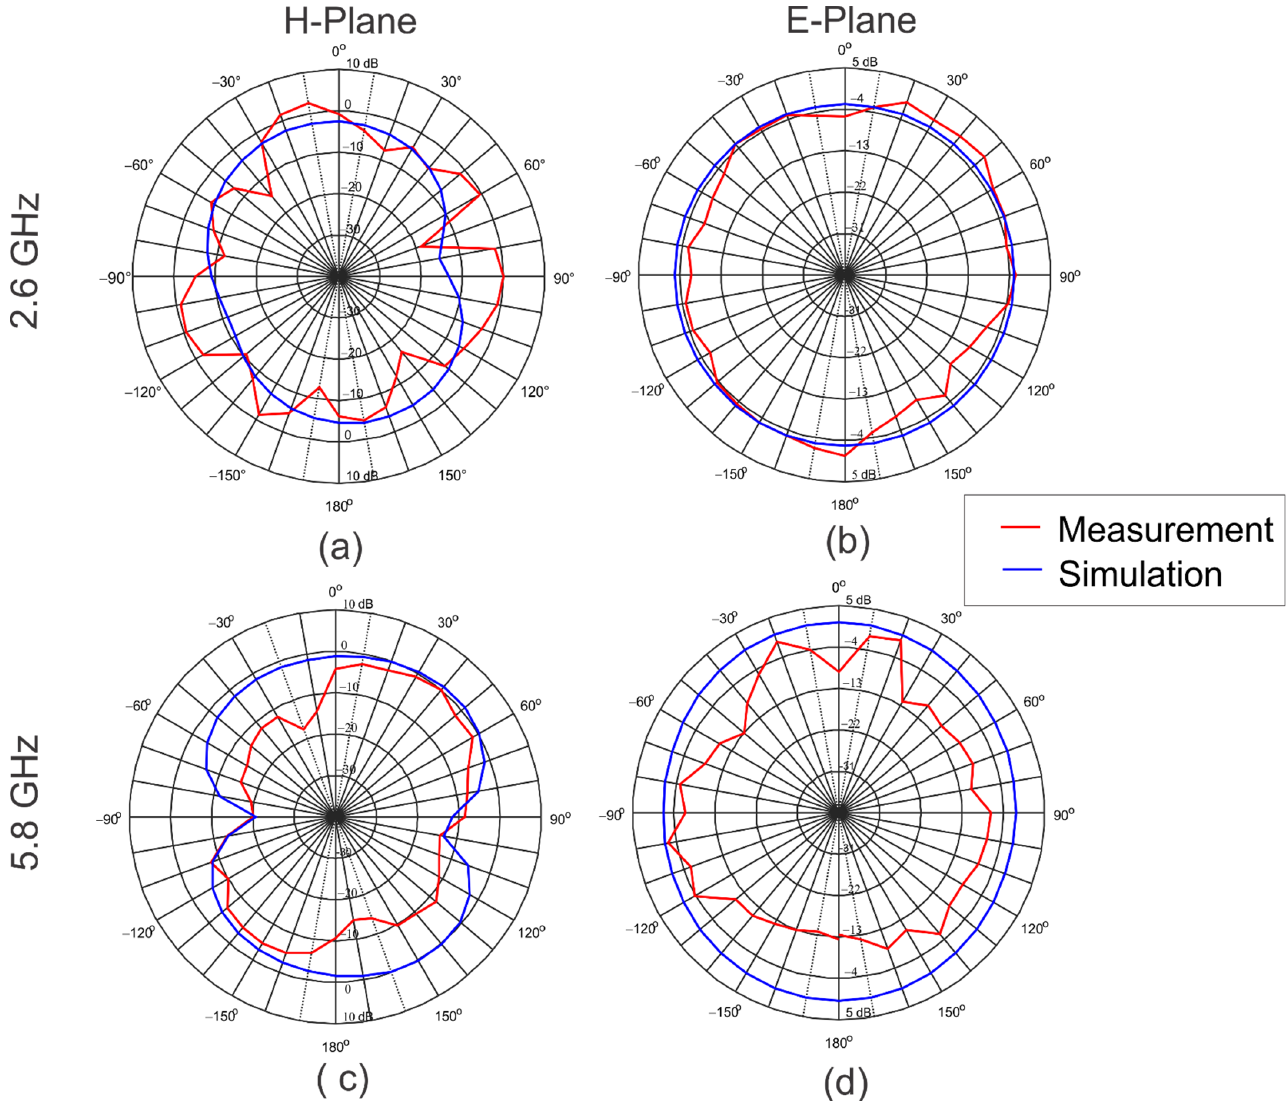
Figure 8. Simulated and measured radiation patterns: ( a ) H ‐ plane 2.6 GHz, ( b ) E ‐ plane 2.6 GHz, ( c ) H ‐ plane 5.8 GHz, and ( d ) E ‐ plane 5.8 GHz. Table 4. Measured and simulated